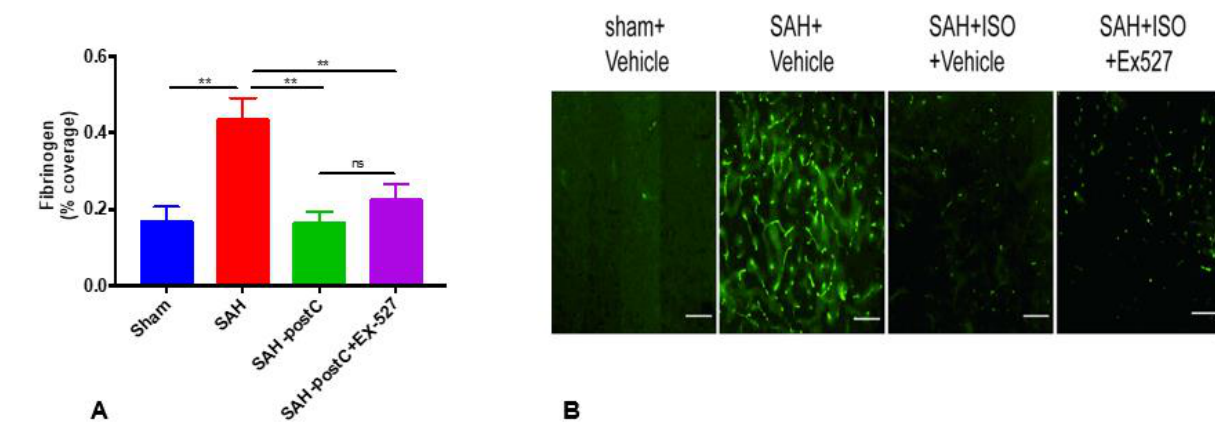
Figure 3. Isoflurane conditioning attenuates SAH-induced microvessel thrombosis with and without EX-527. Wild-type mice were subjected to sham surgery or endovascular perforation SAH and treated with vehicle (DMSO+1.2% cyclodextrin+PBS1X) or EX-527 (10mg/kg) diluted with vehicle. Two out of four groups were exposed to 2% isoflurane for one hour (postC), one hour after SAH, and one isoflurane group out of two received a single dose of EX-527 immediately after SAH. Microvessel thrombosis was assessed on day 3. Data indicate mean ± SEM. ( A ) ** p < 0.01 sham vs. SAH, ** p < 0.01 SAH vs. SAH-postC, SAH-postC+EX-527, p > 0.05 SAH-postC, SAH-postC+EX-527, by ANOVA and Newman–Keuls multiple comparisons test. ( n = 5) ns—nonsignificant. ( B ) Representative images for microvessel thrombosis. ISO—Isoflurane. Scale bar = 100 µm.